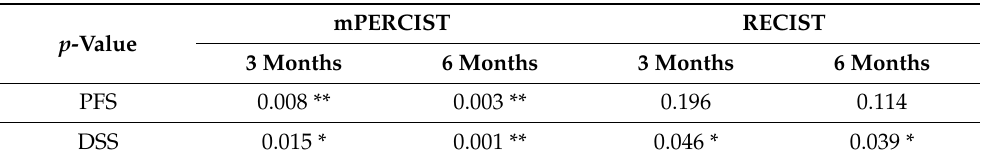
Table 2. Association of PD and DC according to mPERCIST and RECIST to PFS and DSS at the 3 month and 6 month